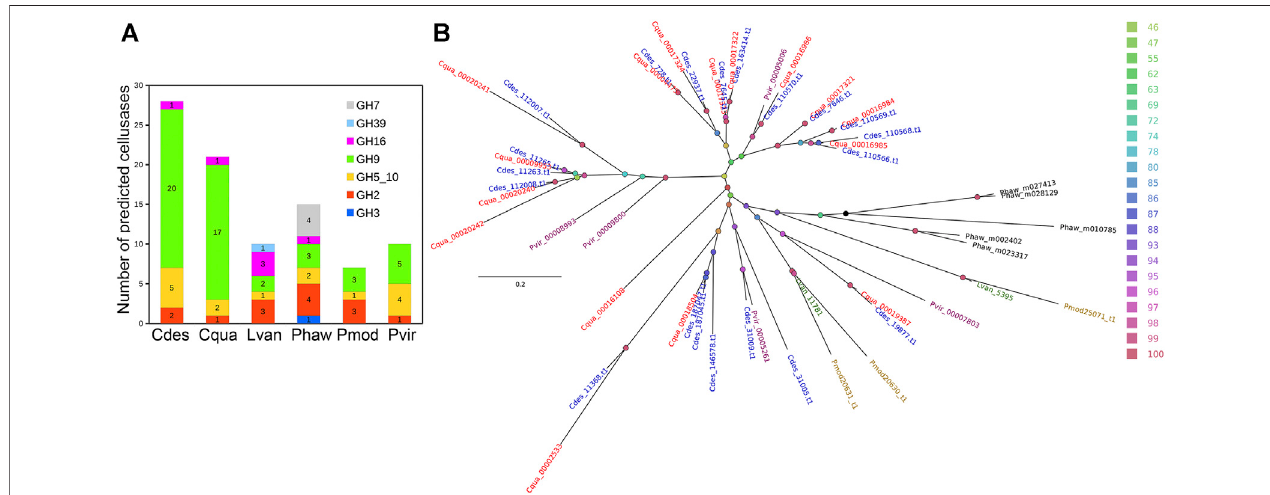
FIGURE 3 | Identi fi cation and phylogenetic analysis of cellulases. (A) Number of identi fi ed cellulases in fi ve decapod crustacean and an amphipod proteomes (B) IQTree maximum likelihood tree showing the evolutionary relationships of GH9 cellulases identi fi ed from the selected proteomes. The nodes were colored based on ultrafast bootstrap values and the fi rst three letters in each tip label correspond to the species name. Branch lengths indicate number of substitutions per site. Cdes, Cherax destructor ; Cqua, Cherax quadricarinatus ; Lvan, Litopenaeus vannamei ; Phaw, Parhyale hawaiensis ; Pmod, Penaeus monodon ; Pvir, Procambarus virginalis